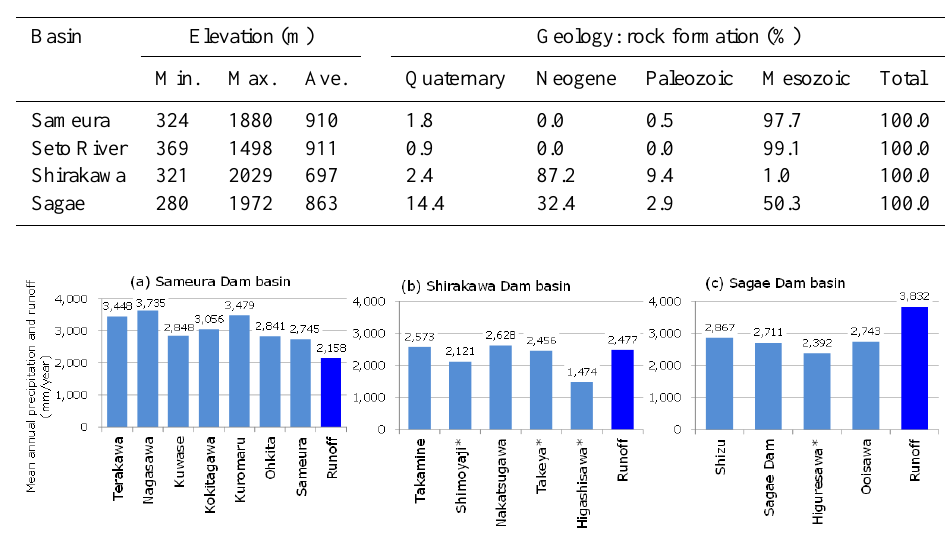
Figure 2. Mean annual precipitation and runoff of (a) Sameura Dam basin, (b) Shirakawa Dam basin, and (c) Sagae Dam basin. ( ∗ Data not available for winter